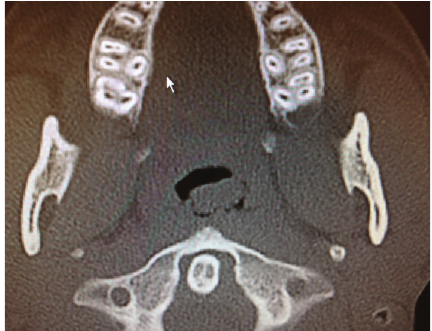
Figure 1: CT axial image demonstrating extension of soft tissue from the nasopharynx on the left side.